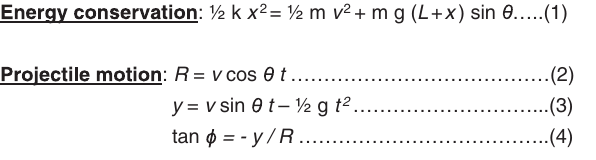
FIG. 3. The four essential equations for tackling the sequential synthesis problems.